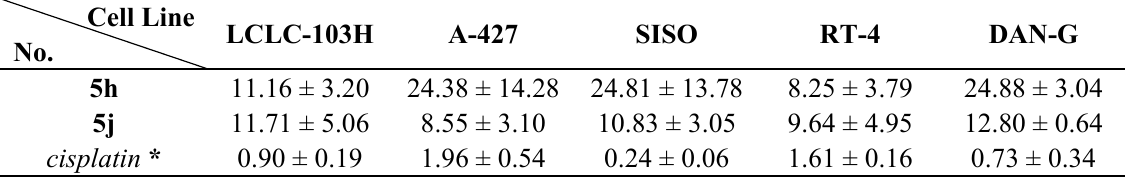
Table 9. IC 50 (µM) values in five human cancer cell lines obtained after 96 h exposure †